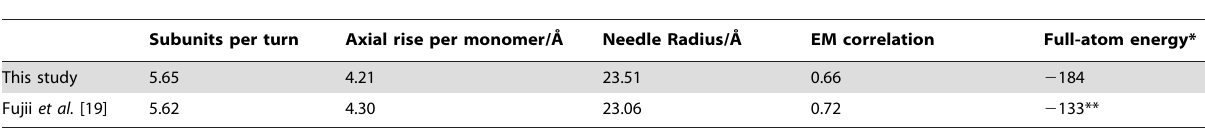
Table 1. Structural statistics of different needle models.